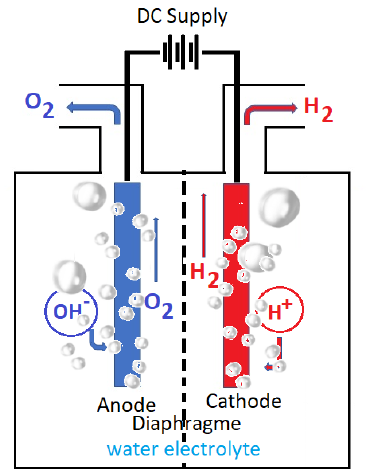
Figure 1. General scheme for water electrolysis.